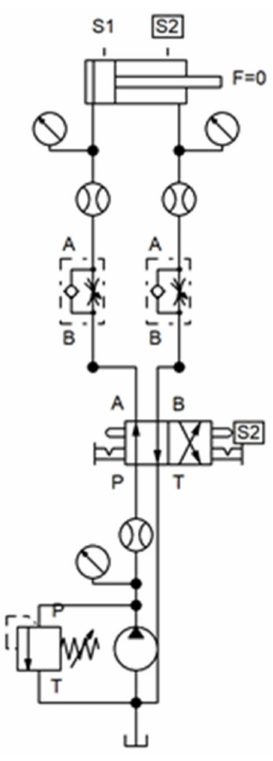
Figure 19. An exemplary hydraulic diagram of the